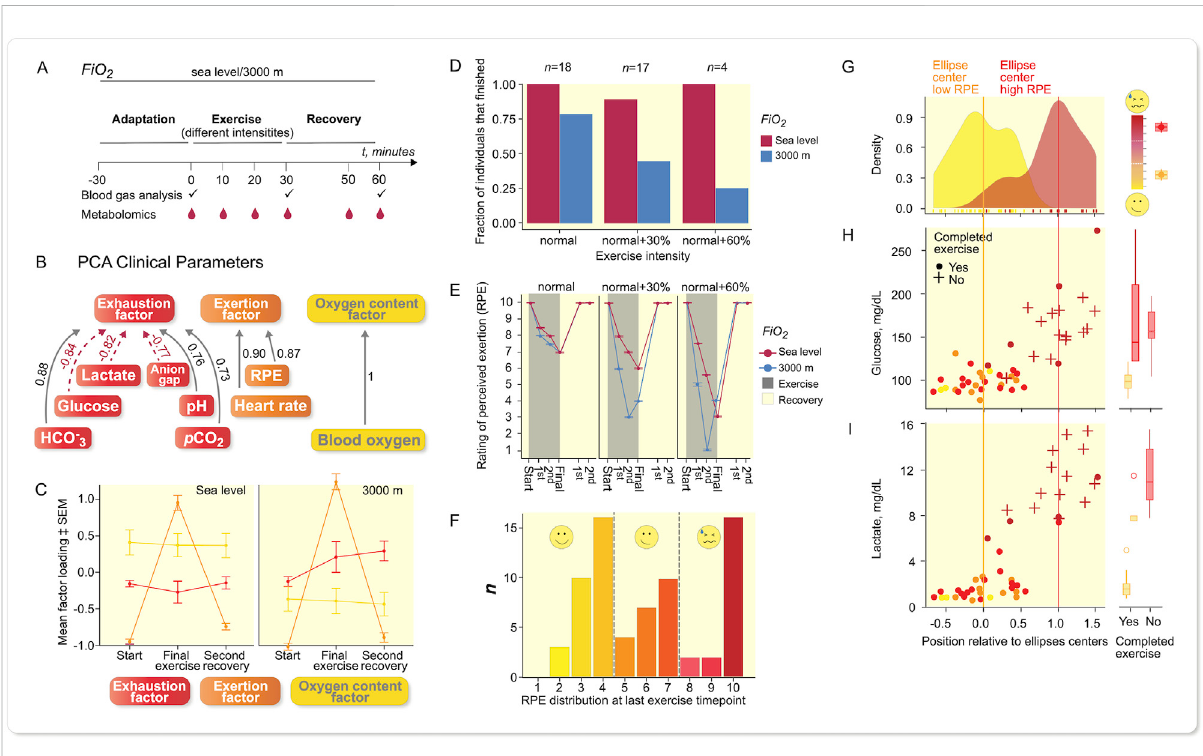
FIGURE 2 Results fromrecreational(normal) volunteers.Samplingscheme forlarger panel studyofrecreationalathletes. (A) Studydesignoutline. (B) PCA ofclinical parametersrevealed threedifferentitems, namely exhaustion,exertion,andoxygen. (C) Whenplottingmean factorloadingsofPCA ofthe three principle components, the data indicate that the oxygen content factor was in fl uenced by Fi O 2 albeit constant throughout the experiment. Exertion was high at last exercise time-point and reaches baseline values during recovery, while the exhaustion increases under more hypoxic conditions and remains elevated during recovery, error bars: SEM, n = 39 at each oxygenation level. (D) The fraction of subjects being able to complete the exercise bouts re fl ects that Fi O 2 had a stronger in fl uence on that with increasing power output (running speed), n given in the fi gure refers to each oxygenation level. (E) Individual RPE values were more different between power output levels; lower Fi O 2 led to more marked